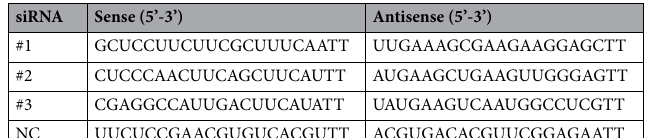
Table 1. The sequence of small interfere RNA.